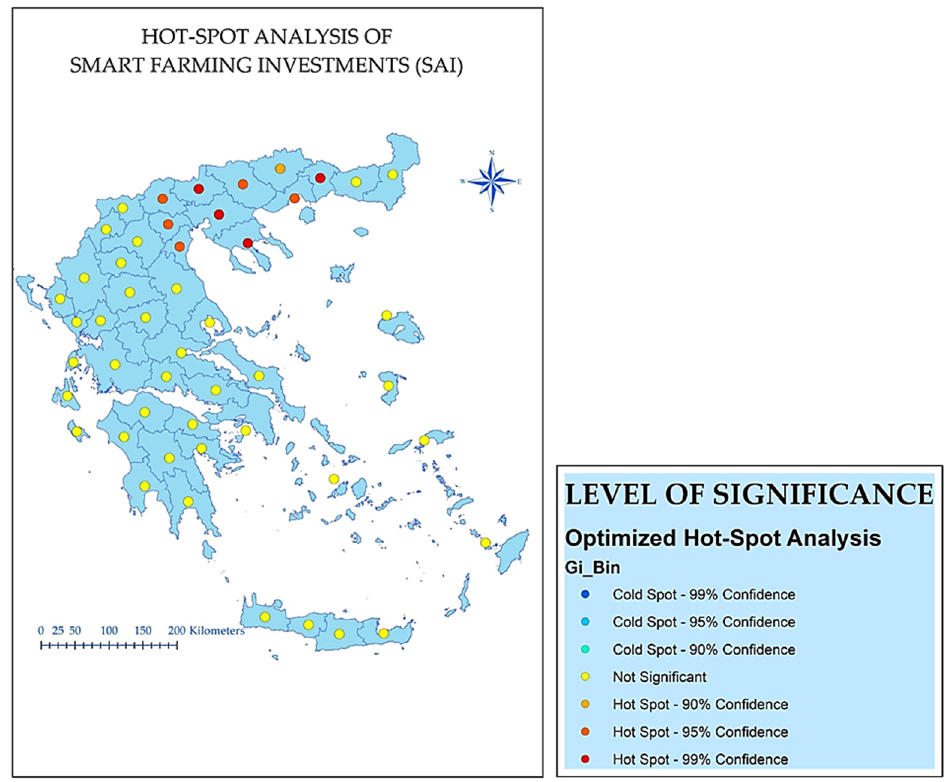
Figure 5. Hot spot analysis of SAI (depicted in ESRI ArcGIS Desktop 10.5-ESRI 2016. ArcGIS Desktop: Release 10.5, Redlands, CA: Environmental Systems Research Institute).